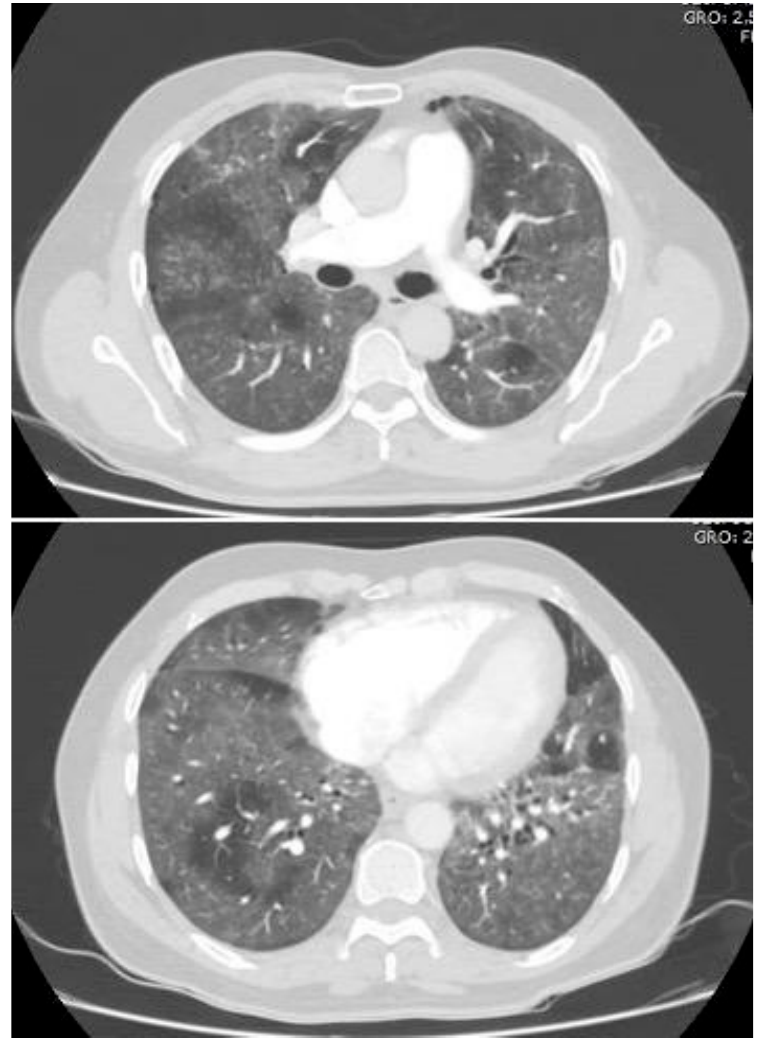
Figure 1. Chest computed angiotomography on admission showing diffuse ground-glass opacities with subpleural compromise and septal thickening. Negative for pulmonary embolism. Table 1. Laboratory findings on admission and during hospitalization.